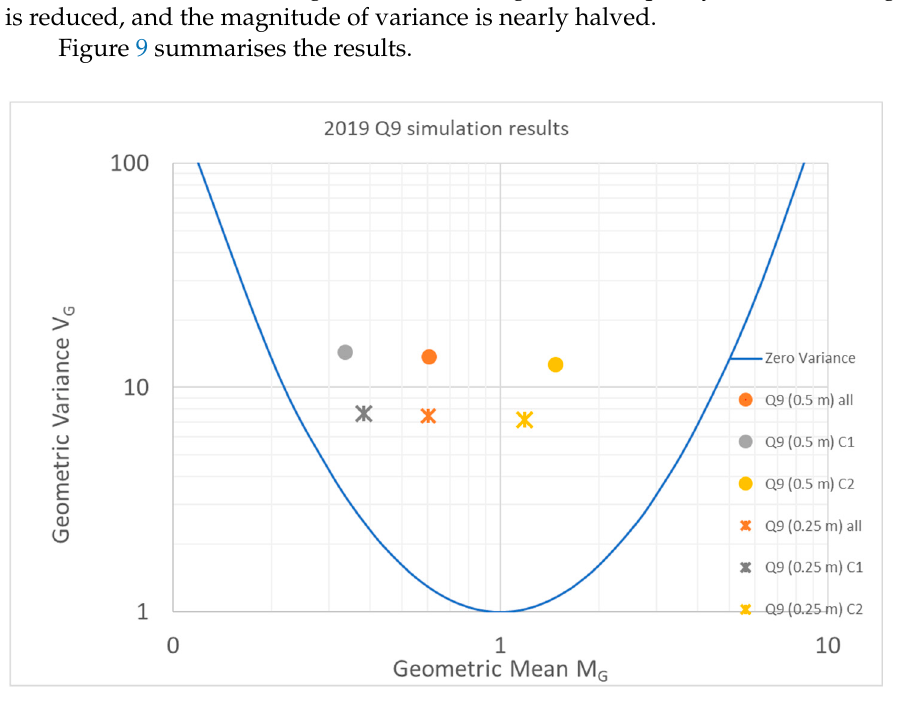
Table 4. Geometric means and variance: Q9 Cloud volumes calculated by FLACS was used as an input to explosion simulations.